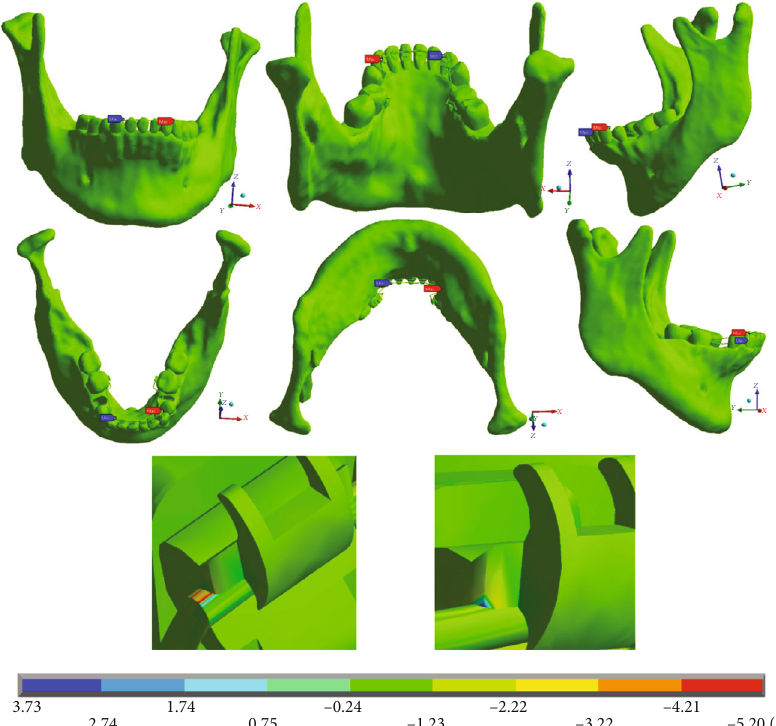
Figure 14: Normal stresses in the Y complete system (mandibular bone, dental organs, brackets, and wires). The red marker indicates the maximum stresses, and the blue marker indicates the minor